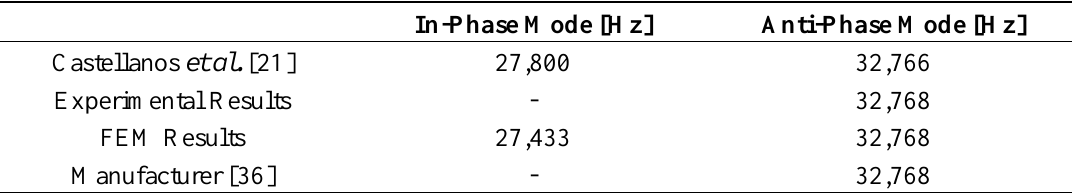
Table 1. Resonance frequency for the in-phase and anti-phase vibrational modes.